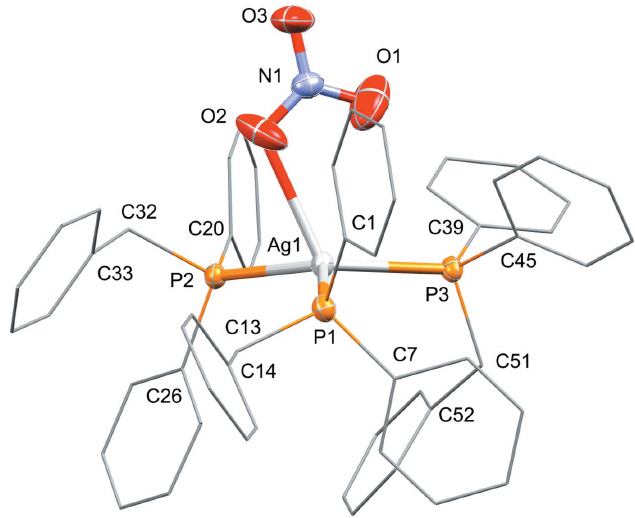
Figure 1 Molecular structure of the silver(I) tris-phosphine complex. Displace- ment ellipsoids are drawn at the 50% probability level. For clarity, selected carbon atoms of the arene rings are shown in wireframe style and hydrogen atoms are